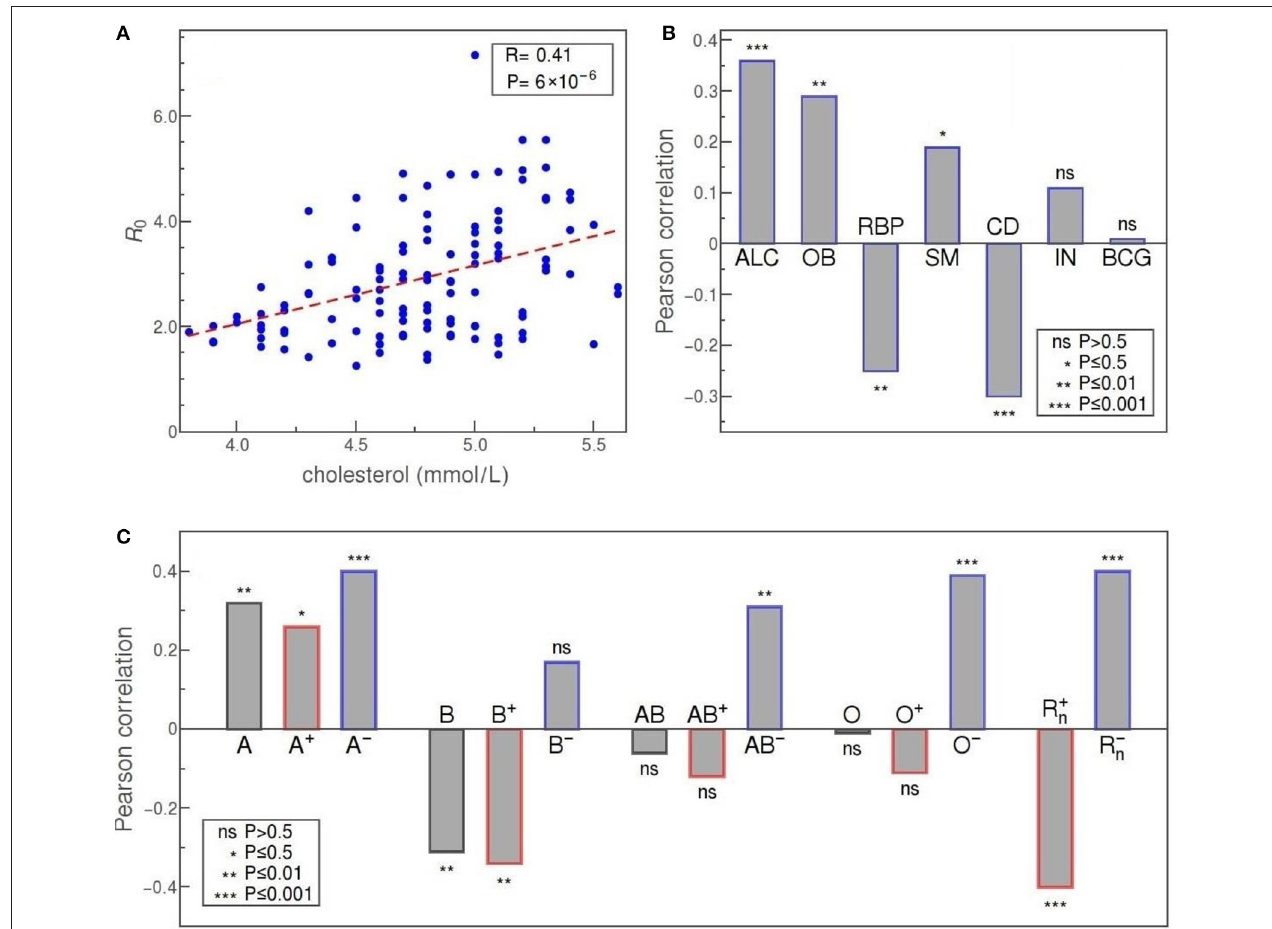
FIGURE 5 | (A) R 0 vs cholesterol level, as an example of a health-related parameter dependence. (B) Pearson correlation of R 0 with (from left to right): alcohol consumption per capita (ALC); the prevalence of obesity (OB); severity of COVID-19 relevant chronic diseases in the population (CD); a percentage of people with raised blood pressure (RBP); a percentage of smokers (SM); the prevalence of insufficient physical activity among adults (IN); BCG immunization coverage among 1-year-olds (BCG) (C) Correlation of blood types with R 0 in order: A, B, AB, and O (from left to right); overall value for that group, correlation only for Rh + subtype of the group, and correlation for Rh − subtype is shown. The two rightmost bars correspond to the overall correlation of Rh + and the overall correlation of the Rh − blood type with R 0 . The convention for representing the statistical significance of each correlation is the same as in Figure 4